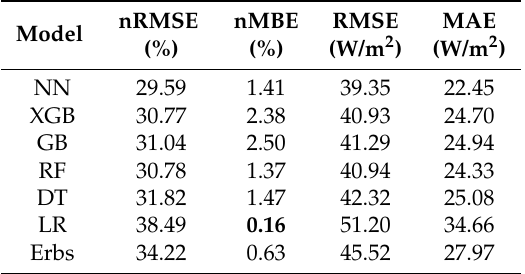
Table 8. The performance metrics of different models on Ensheim climate for diffuse horizontal irradiance on 2017